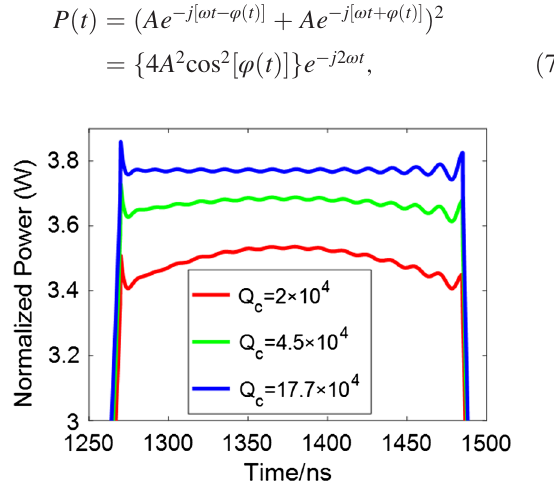
FIG. 6. Top shapes of the output pulses with different unloaded Q-factors of correction cavities. The output pulse length is 250 ns and the compression ratio is 6. The Q s is 1 . 77 × 10 5 and the number of correction cavities is